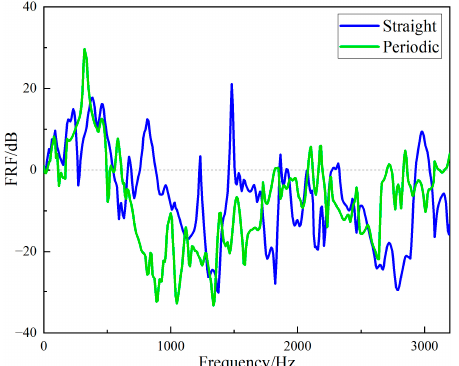
Figure 20. Frequency domains FRF of the two different specimens.